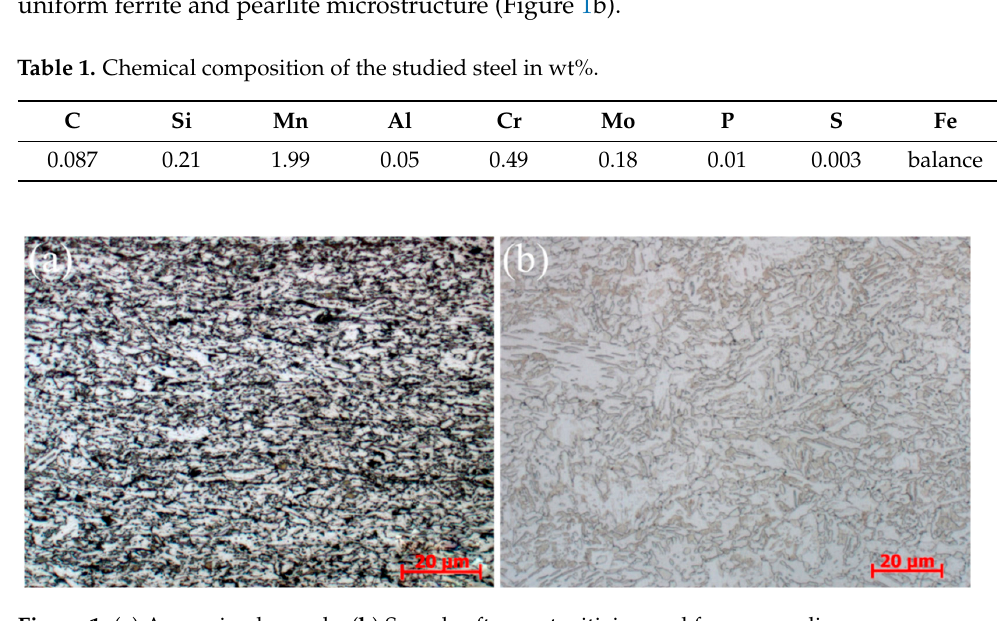
Figure 1. ( a ) As-received sample; ( b ) Sample after austenitizing and furnace cooling.